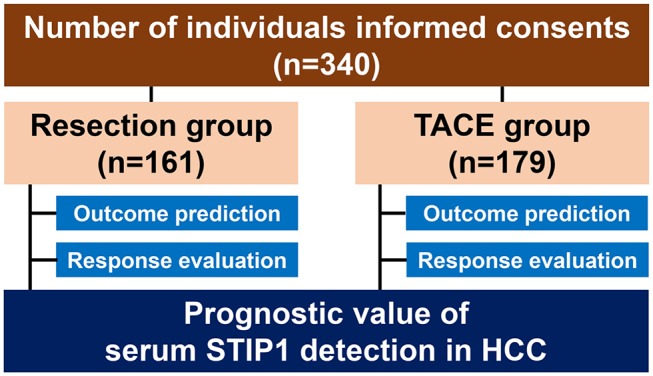
Schematic diagram of present study.